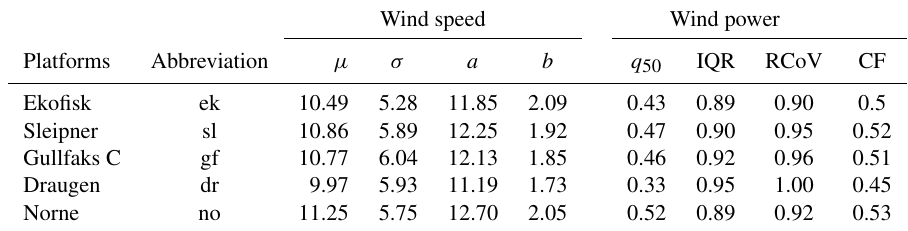
Table 2. Statistical measures of the wind speed and wind power. µ and σ are the Weibull mean and standard deviation, respectively, a and b are the scale and shape parameter of a Weibull distribution, respectively, q 50 is the median (second quartile), IQR is the interquartile range, RCoV is the robust coefficient of variability, and CF is the wind power capacity